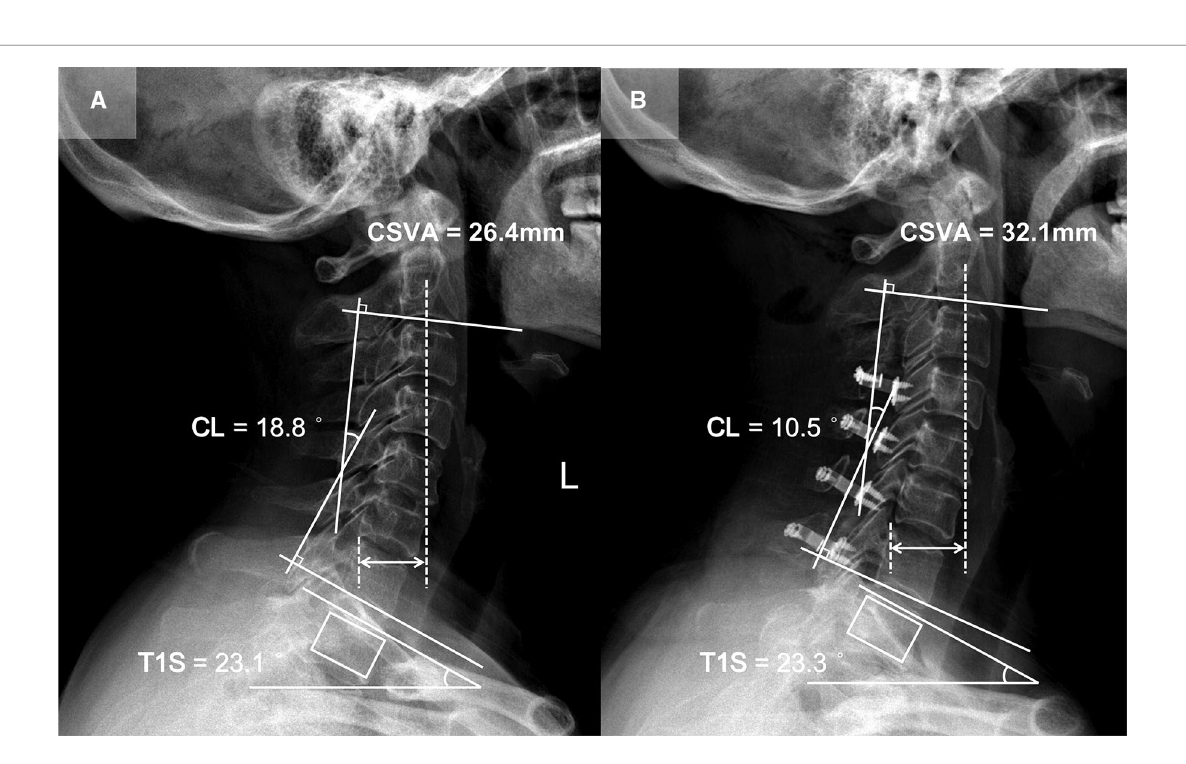
FIGURE 5 Patient case of the CL loss group, T1S sustained subgroup. ( A ) Preoperative lateral cervical radiograph (CL=18.8°, T1S=23.1°, CSVA=26.4 mm). ( B ) Lateral cervical radiograph at fi nal follow-up (14 months after surgery, CL=10.5°, T1S=23.3°, CSVA=32.1